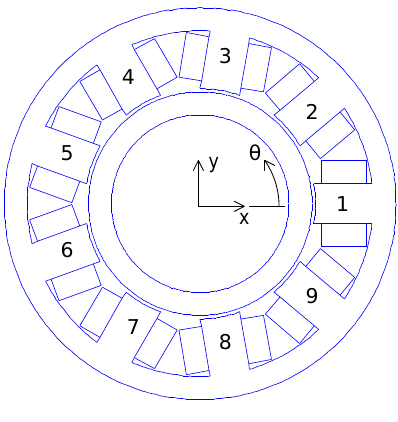
Figure 2. Nine-pole bearing showing pole